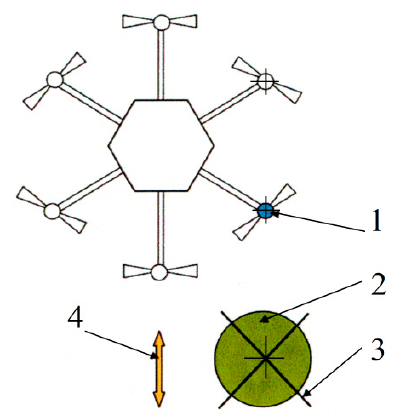
Figure 1. The drone position in relation to the trees being sprayed: 1—drone rotor, under which the nozzle is mounted, 2—samplers, 3—position of the trees in relation to the nozzle, 4—direction of the drone